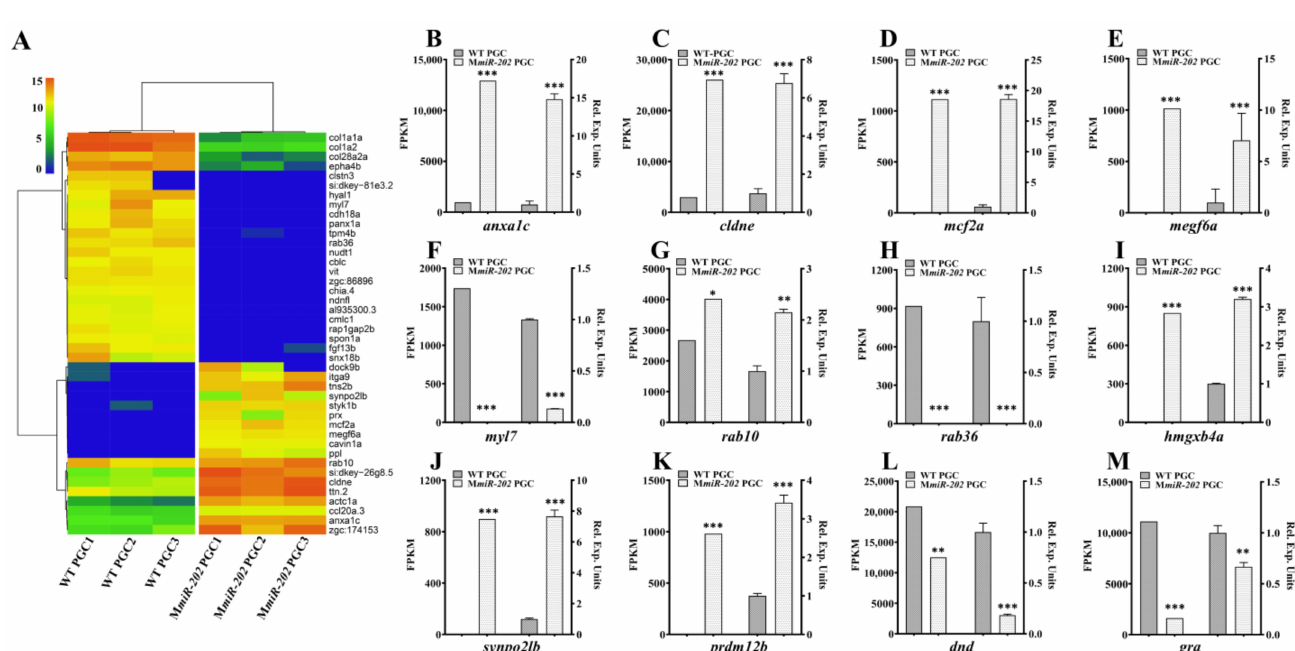
Figure 2. Heatmap of representative DEGs related to cell migration and verification of the expression patterns by qPCR analysis. ( A ) Two-dimensional hierarchical cluster of DEGs associated with cell migration. ( B – M ) Validation of the transcriptome by qRT-PCR analysis of representative genes including ( B ) anxa1c , ( C ) cldne , ( D ) mcf2a , ( E ) megf6a , ( F ) myl7 , ( G ) rab10 , ( H ) rab36 , ( I ) hmgxb4a , ( J ) synpo2lb , ( K ) prdm12b , ( L ) dnd and ( M ) gra . The FPKM values (left) and the relative expression levels of qPCR (right) are shown. ( B – G ) The results were representative of more than three independent experiments in triplicate. Three reference genes ef1a , β -actin and rpl13a were used in every PCR examination to normalize gene expression levels with 2 − ∆∆ Ct method. The statistics were calculated and analyzed by Student’s t -test, * p < 0.05; ** p < 0.01; *** p <